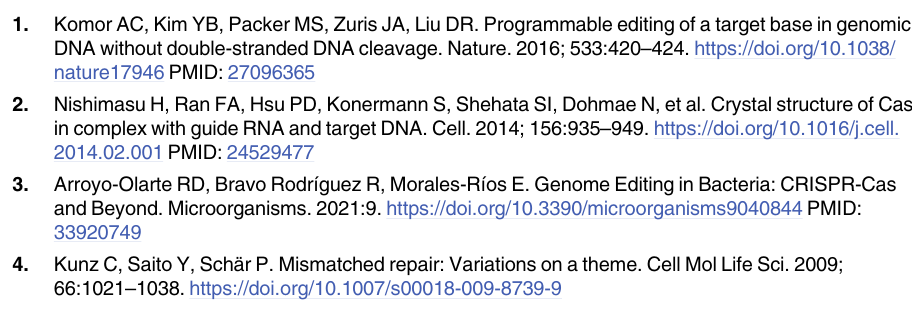
S1 Table. Sampling of prominent biotechnology companies within the gene editing thera- peutics field. Information presented is an extension of Fig 2, across a broader range of bio- technology companies. In the interest of space, the following set of exclusionary criteria was used to determine the final list of companies represented: non-CRISPR or base editor-based technology, not based in the US, acquired by a larger company (larger, acquiring companies may be included), solely cell therapy–focused, large-scale pharmaceutical companies, and non- human based research